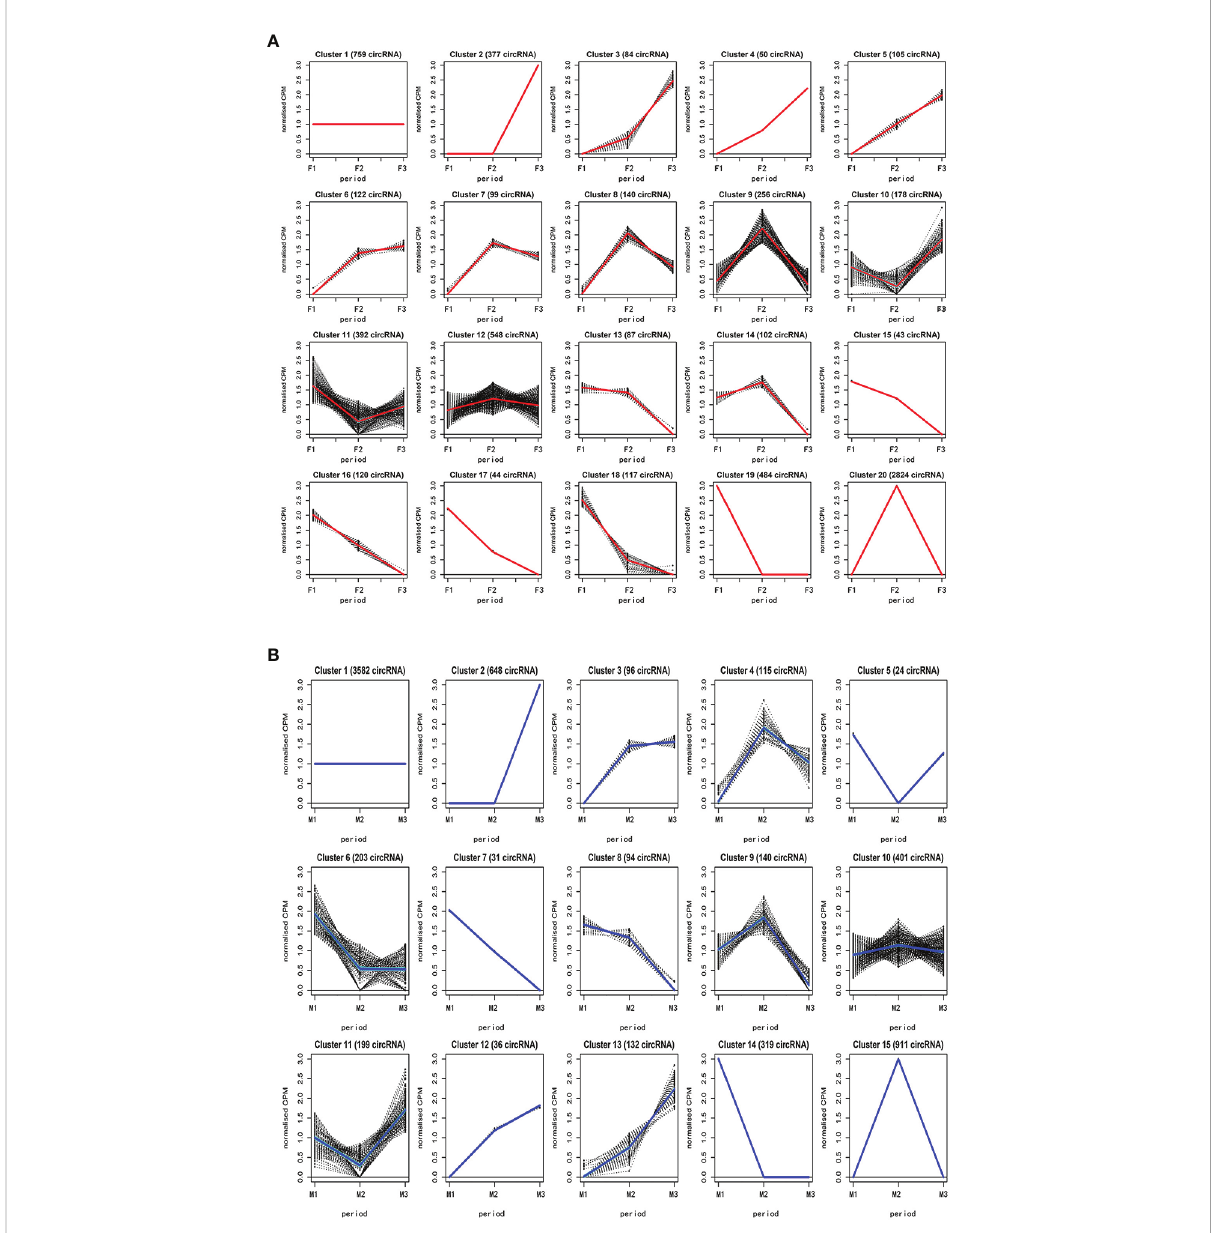
FIGURE 2 The hierarchical clustering analysis of circRNAs in female and male buds. The circRNAs in female hickory fl ower buds were divided into 20 clusters (A) while the circRNAs of male fl ower buds were grouped into 15 clusters (B) . The analysis was performed with the Bayesian approach to reveal the expression pro fi le of circRNAs in female and male bud using relative mean counts per million (CPM) counts. F, female; M, male; F1 and M1, undifferentiated stage; F2 and M2, differentiating stage; F3 and M3, fully differentiated